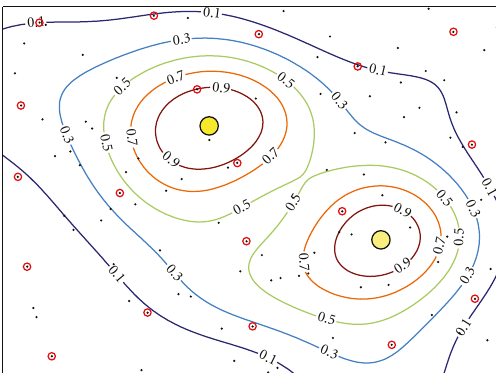
Figure 6: Spatial distribution of temperature estimated using 100 sensors. Parameters were set as follows: ρ = 0 . 3, β 0 = 0 . 24, ν = 0 . 30, σ = 0 . 1. The resulting model order was m = 19. The x heat sources are represented by two yellow discs. The sensors are indicated by black dots. The latter are red-circled in the case of cluster